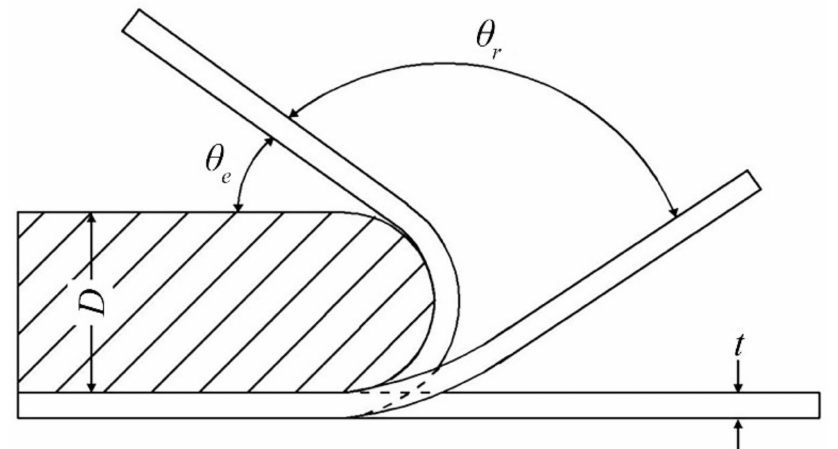
Figure 1. Schematic illustration of bending test for shape memory